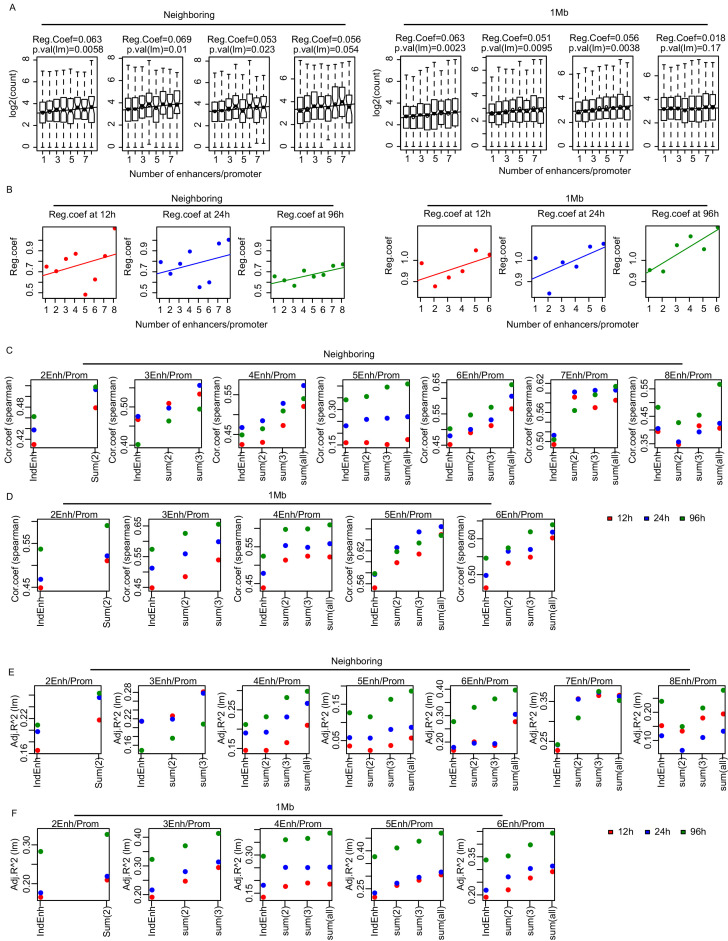
Multiple enhancers activate target gene promoters.(A) mRNA synthesis level (log2 transformed) was greater as number of paired enhancers was increased, both by neighboring and 1 Mb methods. The regression coefficients and p-value of linear regression model (lm) are indicated. (B) Regression coefficients indicating changes in mRNA synthesis over individual eRNA synthesis. Neighboring (left) or 1 Mb (right) methods. (C and D) Spearman's correlation coefficients of mRNA synthesis and individual or the sum of 2, 3, or all of paired enhancers by neighboring (C) and 1 Mb methods (D). (E and F) Adjusted coefficient of determination (R-squared, R2) was calculated from linear regression models (lm) of mRNA synthesis against individual enhancers or against the sum of the indicated number of paired enhancers by neighboring (E) and 1 Mb methods (F).